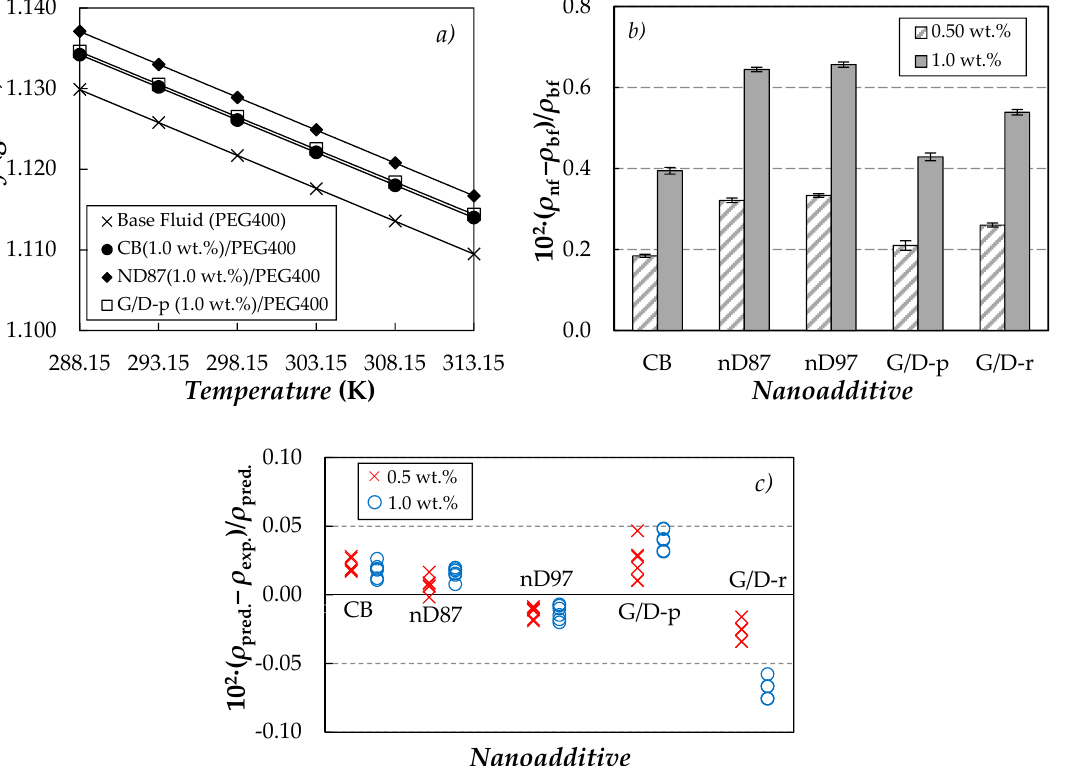
Figure 8. ( a ) Temperature dependence of density for neat PEG400 and nanofluids prepared at the highest nanoparticle concentration, 1.0 wt.%, of ( ) CB, ( (cid:3) ) nD87 and ( (cid:7) ) G / D-p. ( b ) Average density modifications regarding base PEG400, 10 2 · ( ρ nf − ρ bf ) / ρ nf . Error bars represent the standard deviation between values obtained for the different studied temperatures. ( c ) Deviations between experimental densities, ρ exp. , and values predicted using Equation (4), ρ pred .